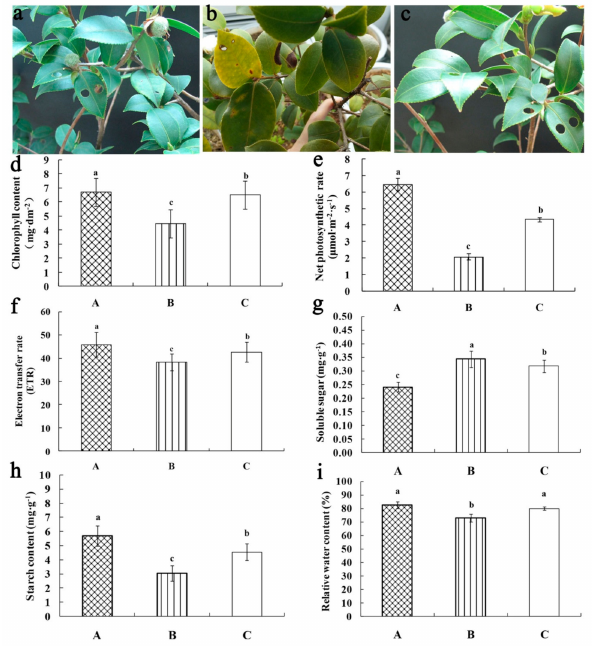
Figure 1. E ff ect of di ff erent temperaturetreatments on phenotypic changes, chlorophyll contents, net photosynthetic rate ( P n ), electron transfer rate (ETR), soluble sugar, starch content, and relative water contentin Camelliaoleifera ‘Huanxin’ leaves. ( a ) 25 ◦ C; ( b ) 6 ◦ C; ( c ) Low environmental temperature; ( d ) Chlorophyll content; ( e ) Net photosynthetic rate; ( f ) Electron transfer rate; ( g ) Soluble sugar content; ( h ) Starch content; ( i ) Relative water content. Data represent the mean ± SE ( n = 3). Lowercase letters indicate significant di ff erences among di ff erent temperature treatments at p ≤ 0.05 according to Duncan’s multiple range test (DMRT).